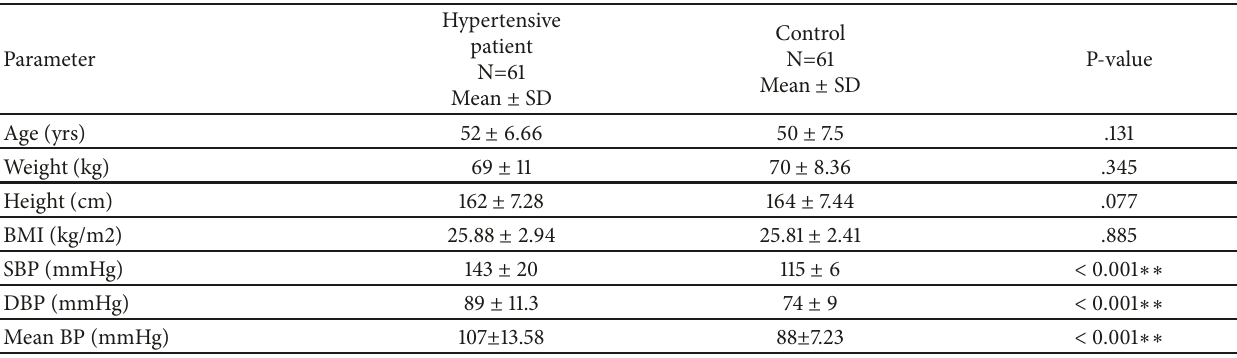
Table 2: Physical characteristics of hypertensive patients and controls at Zewditu Memorial Hospital, Addis Ababa, Ethiopia, 2017.